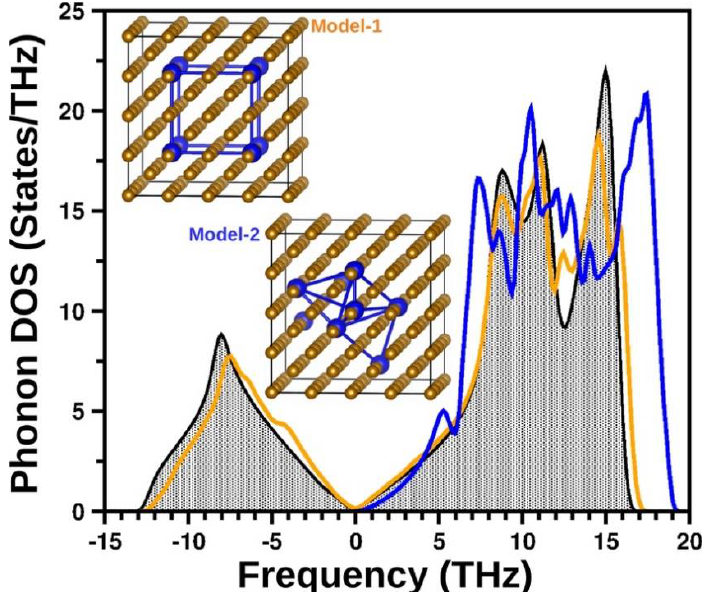
Figure 1. Phonon density of states (DOS) for body-centered cubic (bcc)-Fe (black shaded curve), 6.25% Ni containing bcc Fe-Ni alloy in two different configurations; Model-1: uniform (orange) and Model-2: random (blue) calculated at 364 GPa. The inset shows the corresponding models of the Ni-doped cases for which the phonon DOS has been shown.